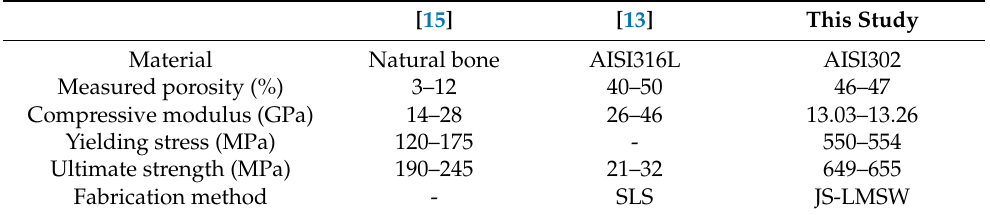
Table 5. Mechanical properties in compression of the human cortical bone and the fabricated scaffold. [15] [13] This